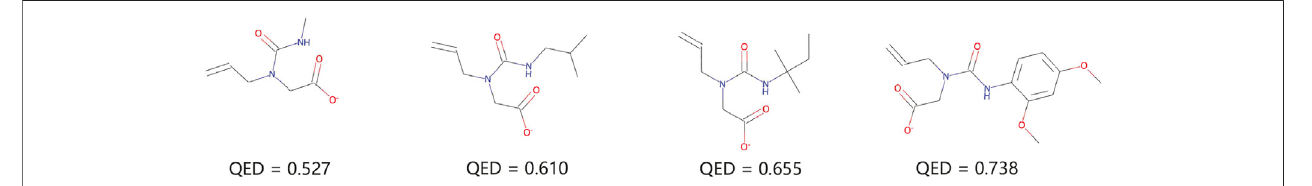
FIGURE 6 | Chemical property optimization. Given the left-most molecule, we optimize the molecule in the direction of maximizing its QED